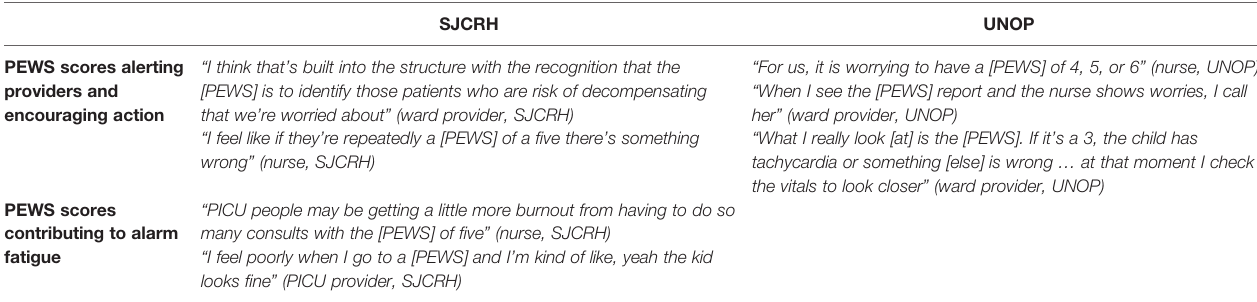
TABLE 3 | Impact of PEWS on provider emotions. SJCRH